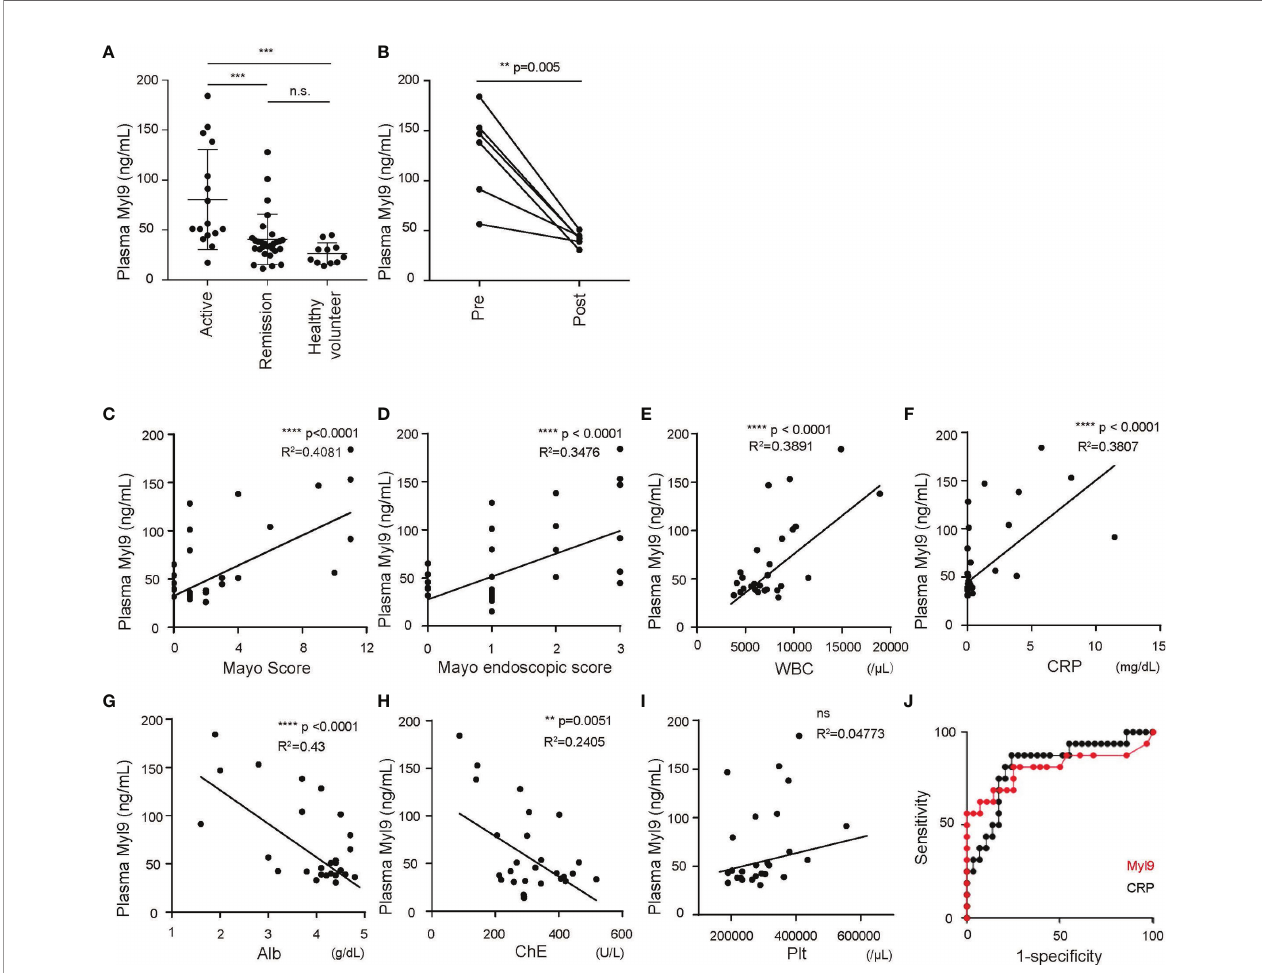
FIGURE 4 | Plasma Myl9 levels depict the disease activity of UC. (A) Plasma Myl9 levels from UC patients with active UC (Mayo ≥ 3) or UC patients who were in remission (Mayo <2) and healthy volunteers (active UC, n = 16, remission, n = 29, healthy volunteers, n = 11). **p < 0.01; ***p < 0.001; ****p < 0.001. (B) The plasma Myl9 levels in the patients before (pre) and after (post) treatment. The Myl9 levels from the same patients are connected. (C – J) The correlations of plasma Myl9 with the Mayo Score (C) , Mayo endoscopic score (D) , WBC count (E) , CRP (F) , serum Alb (G) , serum cholinesterase (H) , and platelet count (I) . (J) ROC curves for Myl9 and CRP in UC patients in remission and those with active UC. ns, not signi fi